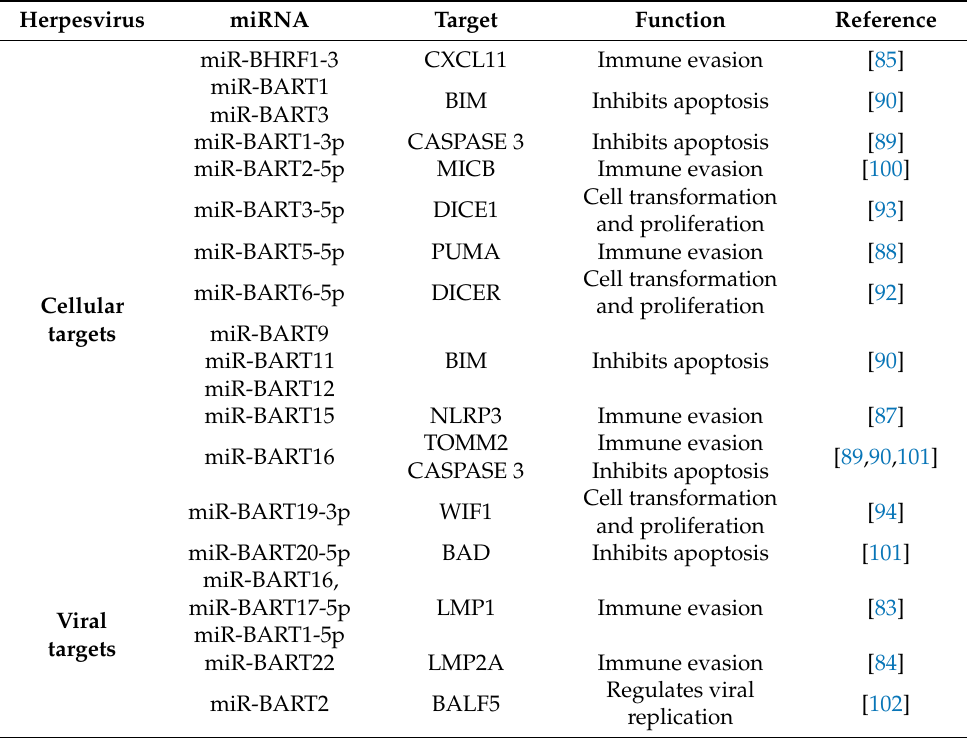
Table 4. Potential cellular and viral targets of EBV miRNAs 4